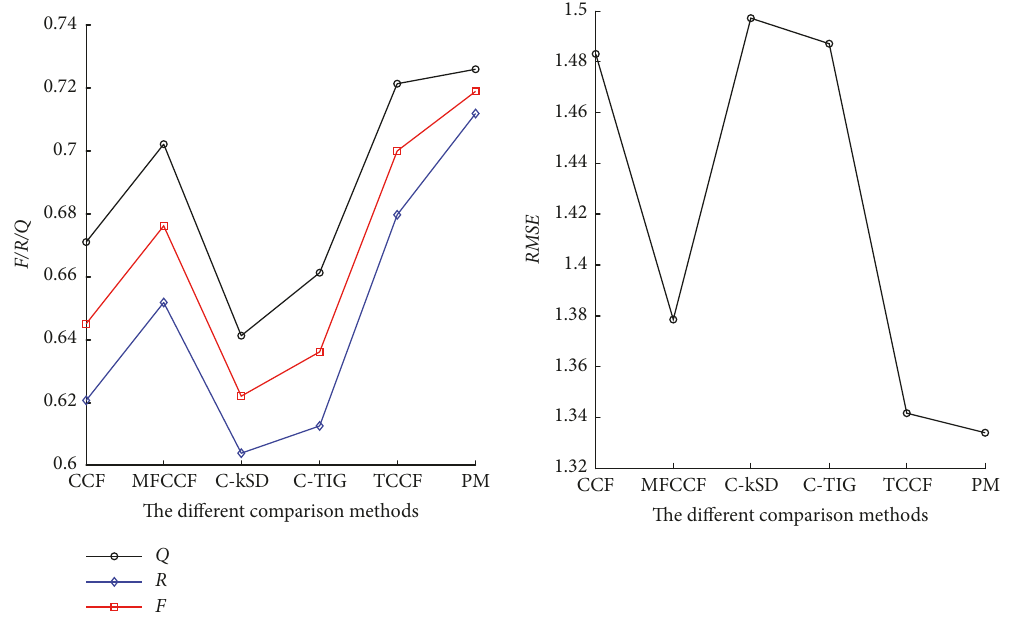
Figure 5: The comparison of the results obtained by different prediction methods in the RM data set.